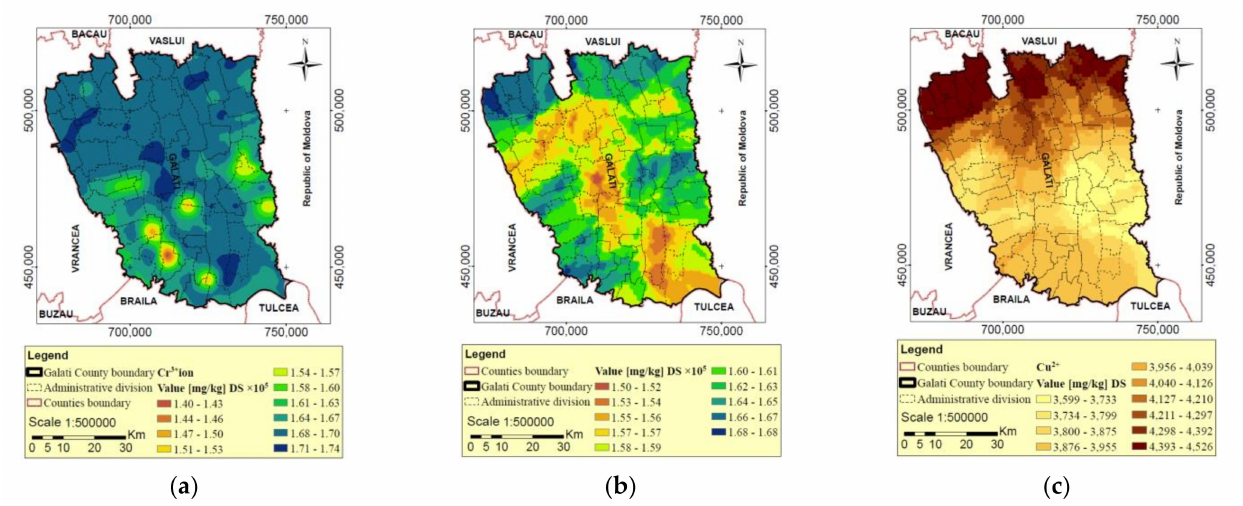
Figure 5. Dispersion model on the agricultural lands in Galati County: ( a ) Cr 3+ ion; ( b ) Ni 2+ ion; ( c ) Cu 2+